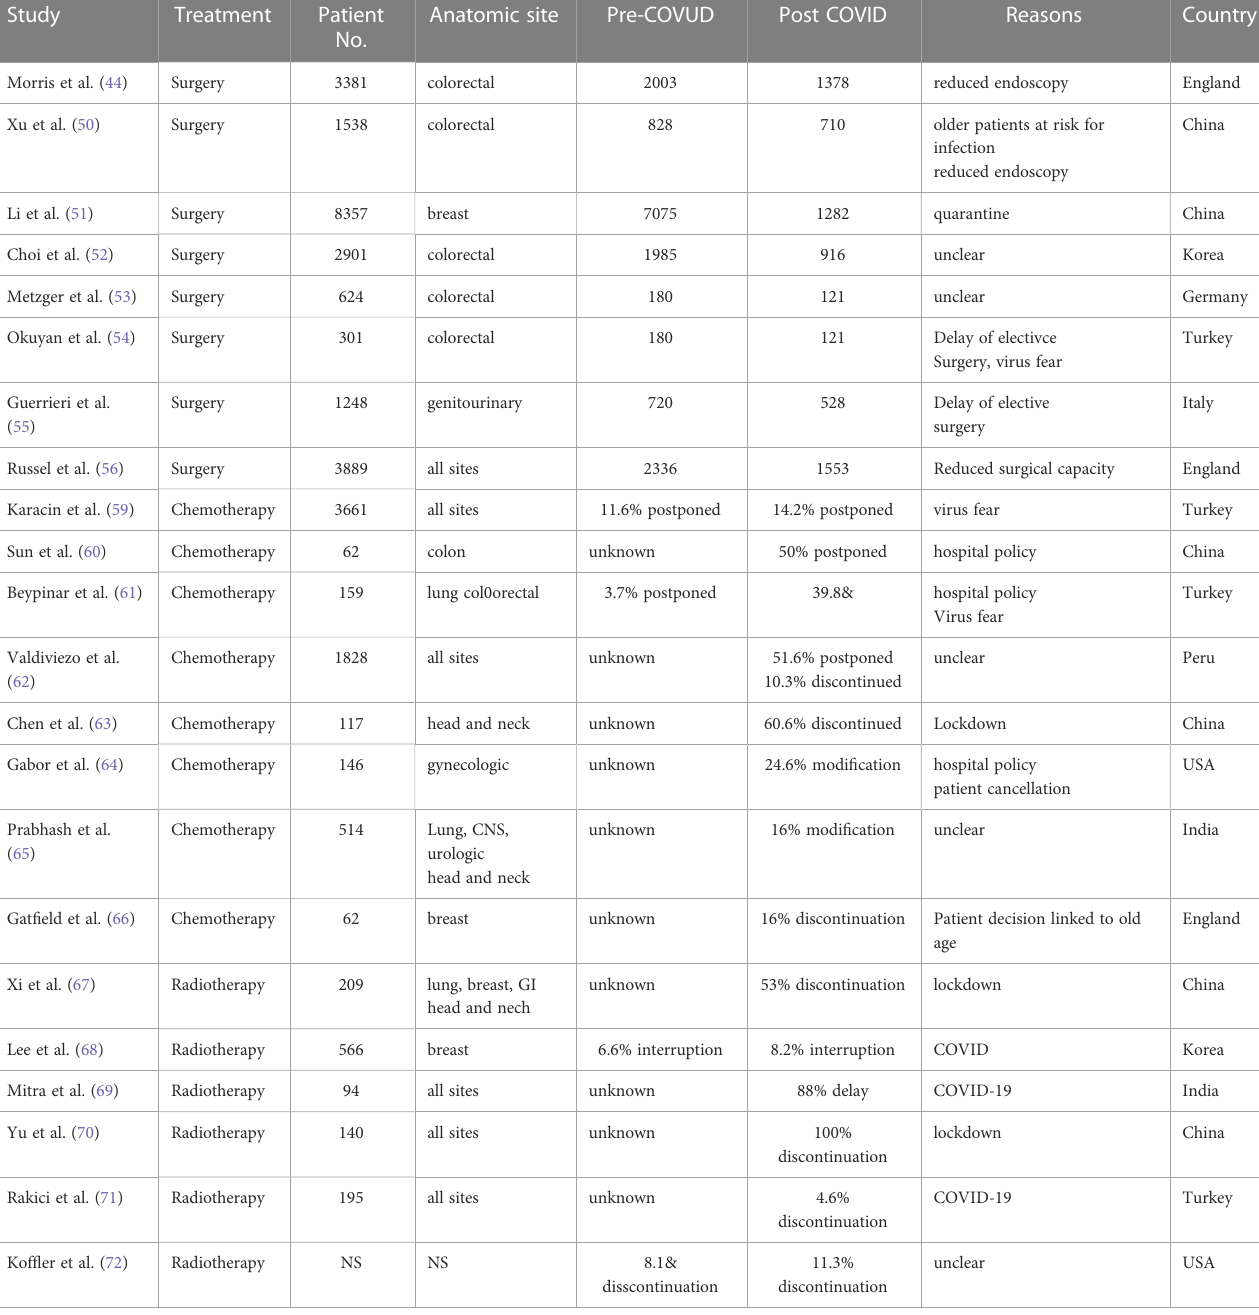
TABLE 2 Decrease or delay in cancer treatment during COVID-19 pandemic.